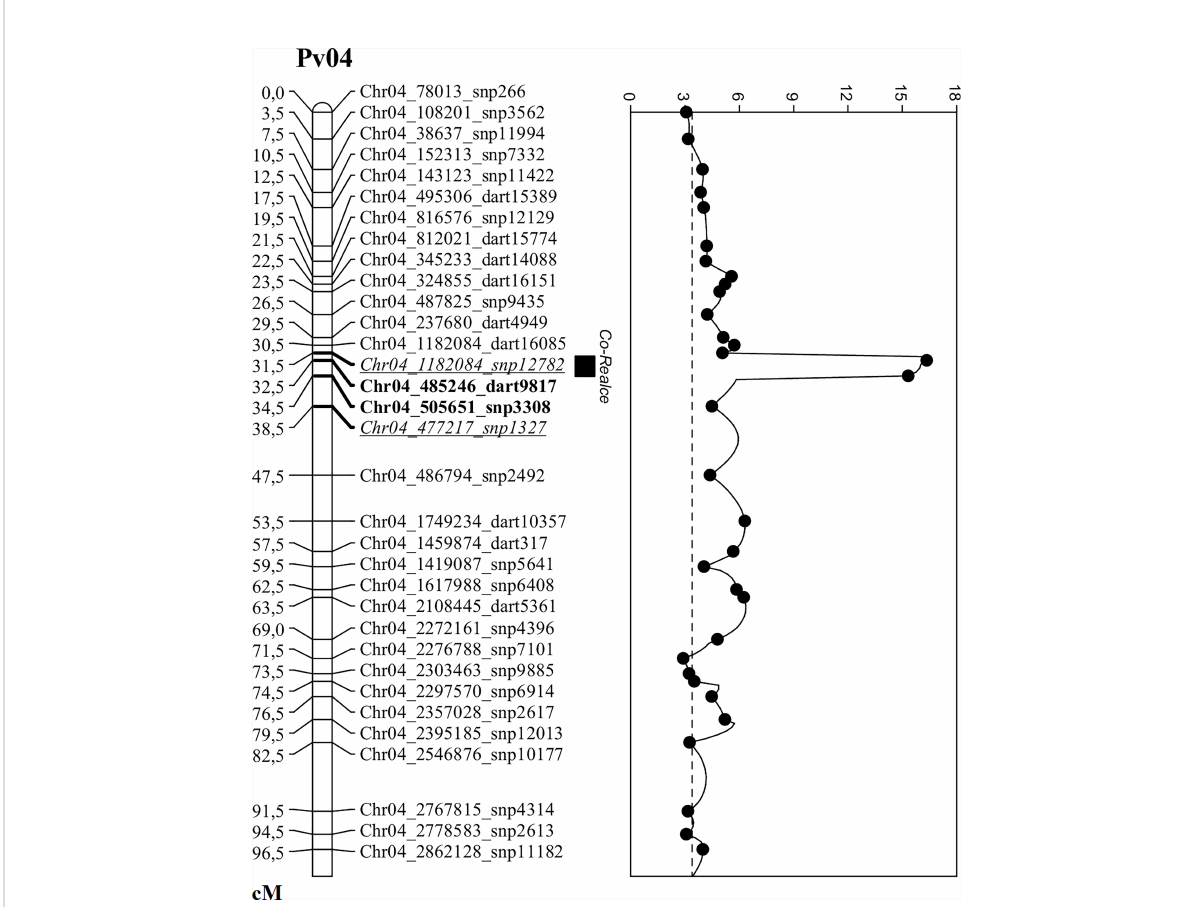
FIGURE 1 Genetic map of the Co-Realce genomic region on the common bean chromosome Pv04. QTL analysis was used to increase the mapping resolution in Co-Realce genomic region, performed using the F 2 population derived from the cross BRSMG Realce × BRS FC104 phenotyped with the Colletotrichum lindemuthianum race 475 and genotyped with SNP and SilicoDArT markers. The two underlined and italicized markers delimit the Co-Realce genomic region. The two bold markers delimit the Co-Realce genomic region after increasing the mapping resolution. The highest peak on Pv4 represents the major locus in the Co-Realce genomic region and the horizontal dashed line is the LOD-score threshold estimated after 1,000